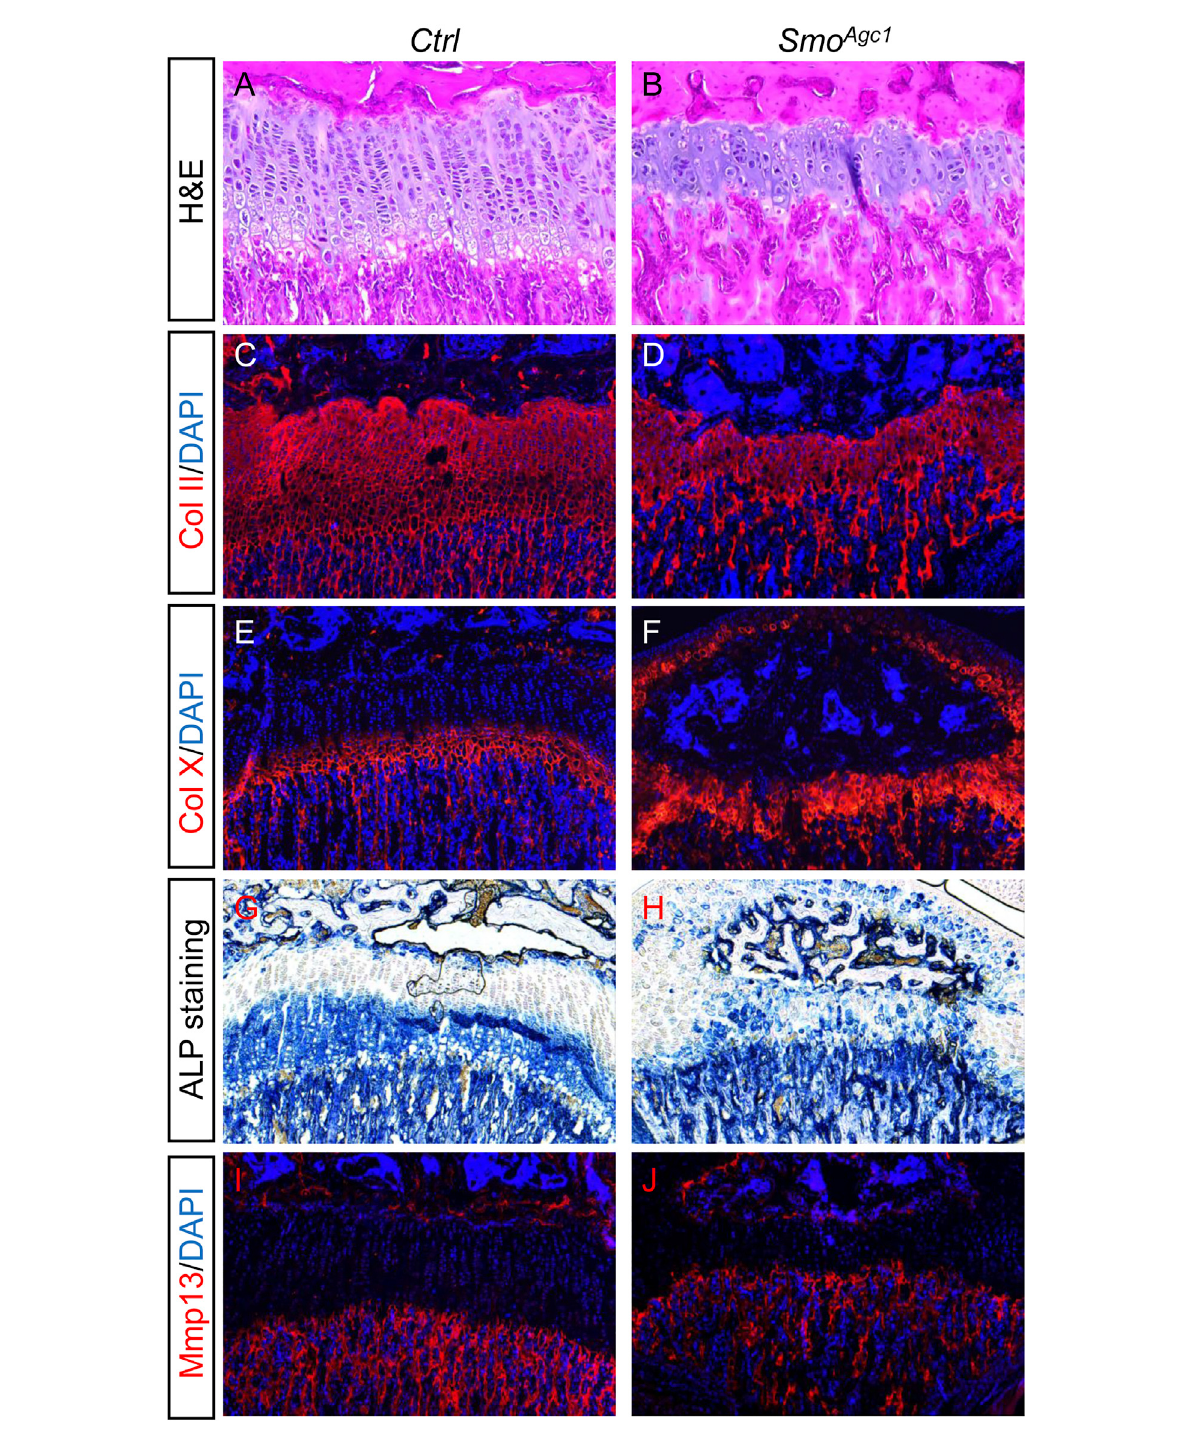
FIGURE 4 Chondrocyte-speci fi c deletion of Smo in juvenile mice led to premature hypertrophic differentiation (A,B) H&E staining of the proximal tibial growth plates from P30 Ctrl (A) and Smo Agc1 mice (B) (C – F) Immuno fl uorescent staining of collagen type Ⅱ (Col II) (C,D) and collagen type X (Col X) (E,F) onfrozensectionsoftheproximaltibialgrowthplatesfromP30 Ctrl (C,E) and Smo Agc1 (D,F) mice (G,H) ALPstainingoftheproximaltibialgrowth platesfromP30 Ctrl (G) and Smo Agc1 mice (H)(I,J) Immuno fl uorescentstainingofMmp13onfrozensectionsoftheproximaltibialgrowthplates from P30 Ctrl (I) and Smo Agc1 (J) mice. All mice were treated with 5 daily doses of tamoxifen starting at